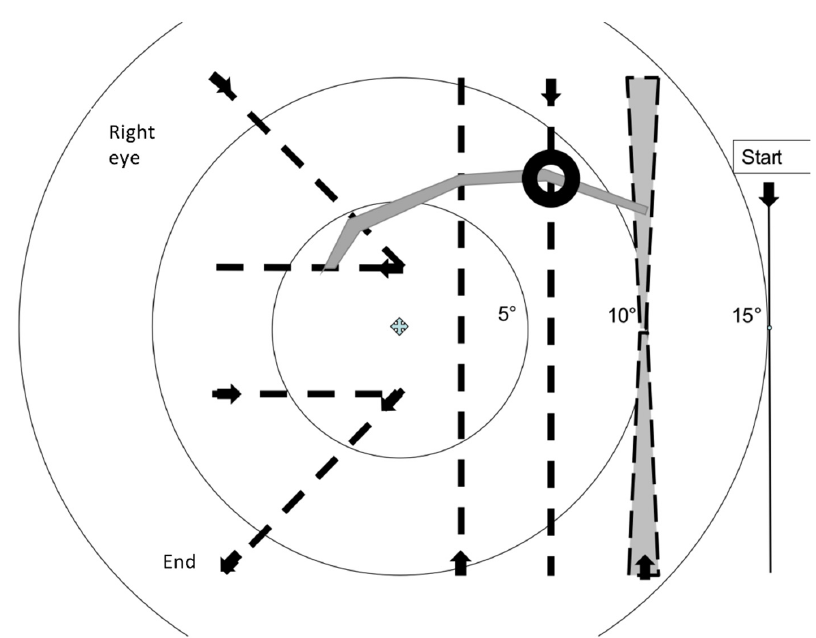
Figure 3. The path tested in the screening procedure of rapid campimetry is shown in dashed lines. In the arc scotoma marked by a black ring, 8° from the fixation point, the optimum test point speed was determined. The test point changes its diameter with the distance from the fixation point; the greater the distance, the greater its diameter. In the outer of the three vertical test lines, the used size change is overdrawn. If one wants to determine the examined area in this area, then the area is calculated as the sum of two identical trapezoids.